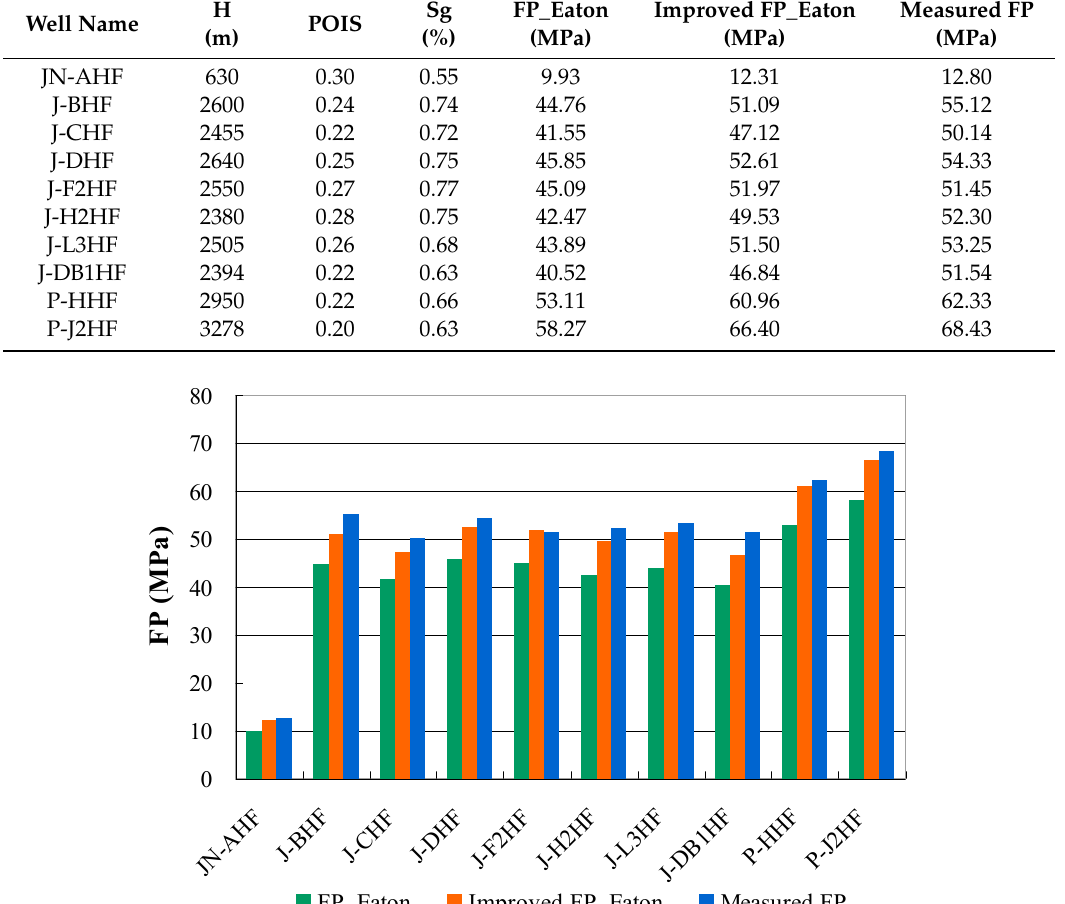
Figure 7. Comparison of calculation results of fracture pressure models with the measured fracture pressure of shale gas wells in Sichuan Basin.